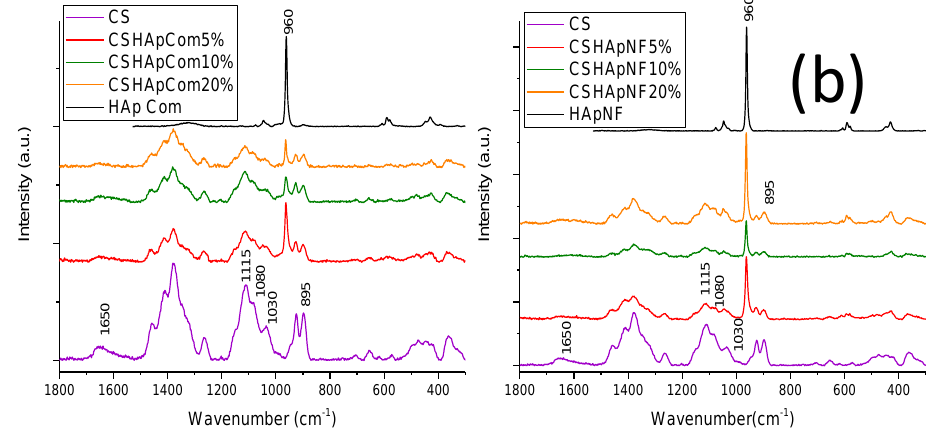
Figure 8. Raman spectra of ( a ) reference materials and ( b ) HAp nanofibers/chitosan composite ma- terials.